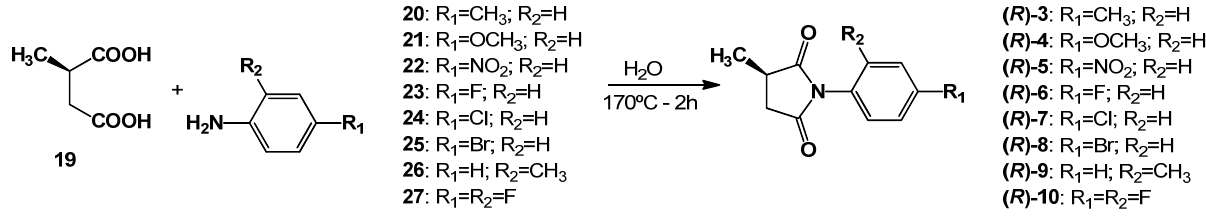
Scheme 2. Synthesis of (3 R )-methyl- N- aryl-succinimides 3 – 10 from (2 R )-methylsuccinic acid 19 and respective anilines 20 – 27 .